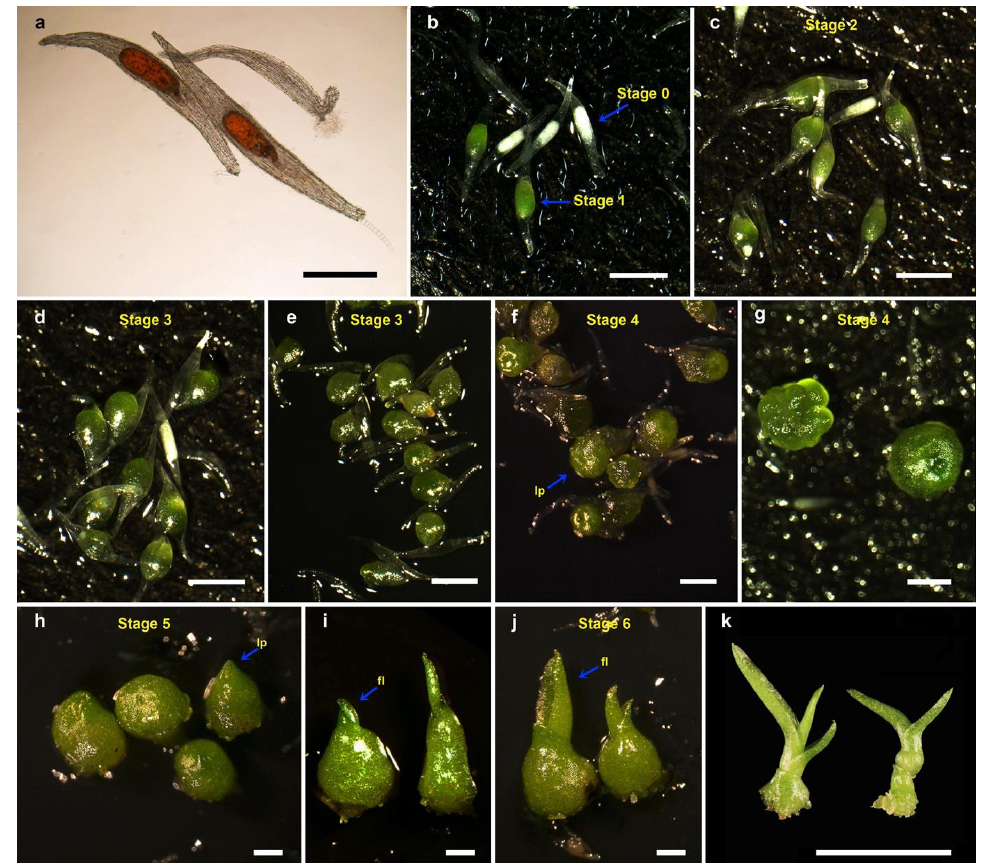
Figure 3. Asymbiotic seed germination and early seedling development of E. geminiflorum on P723 or co-cultured with US266 under 12 h-dark/12 h-light at 20 °C ( a ) Viable TTC-stained seed. ( b ) Stage 0 and imbibed seeds (Stage 1). ( c ) Germinated seeds after 14 days culture on US266. ( d , e ) Globular green Stage 3 protocorms. ( f , g ) Protocorms with leaf primordia (lp) formation. ( h ) Seedlings with elongated leaf primordia (lp) (Stage 5). ( i , j ) Formation of first leaf (lf). ( k ) Seedlings with larger leaves growing on P723 at 42 wks. Scale bars = 500 µ m ( a – f ) and 5 mm ( k